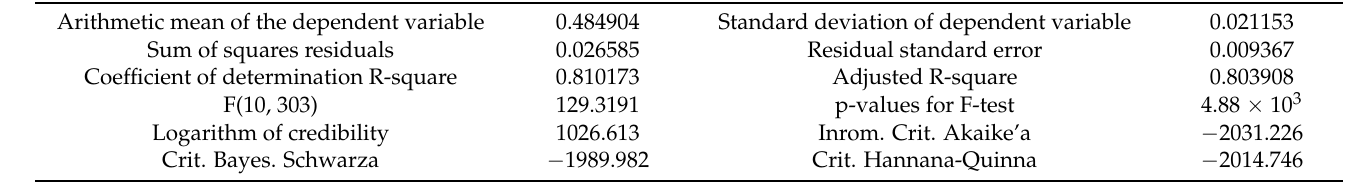
Table 8. Results of regression analysis for the synthetic measure green